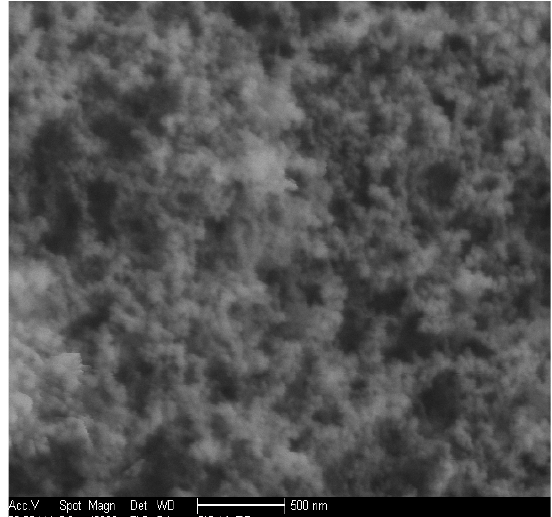
Figure 1. Scanning electron microscopy (SEM) of the nanoscale